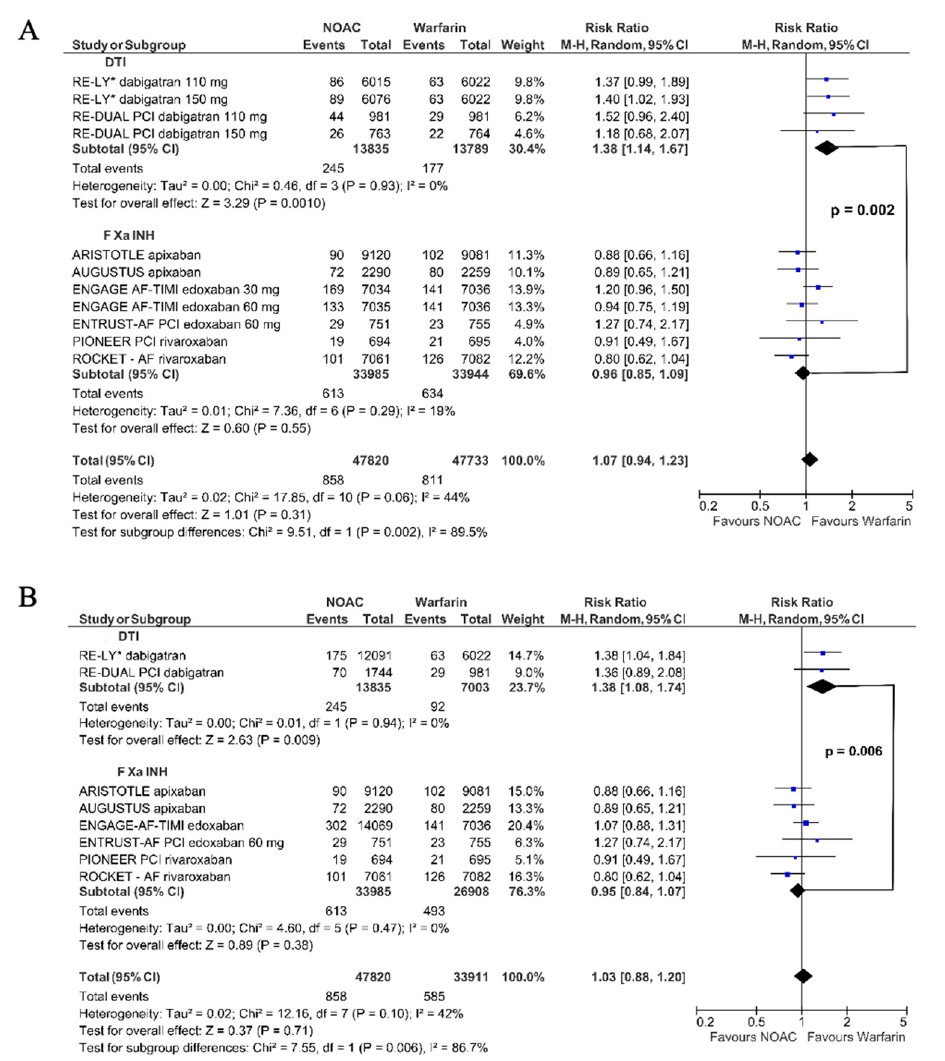
Figure 2. The meta-analysis results for myocardial infarction. * original data from RE-LY study [23]. ( A )—dabigatran dose dependent analysis; ( B )—dabigatran dose independent analysis.